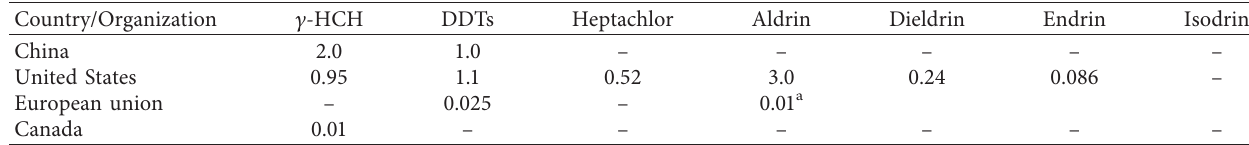
Figure 3: Seasonal compositions and of HCHs (a) and DDTs (b) of sampling points. Table 3: Surface water OCPs concentration standards ( μ g · L − 1